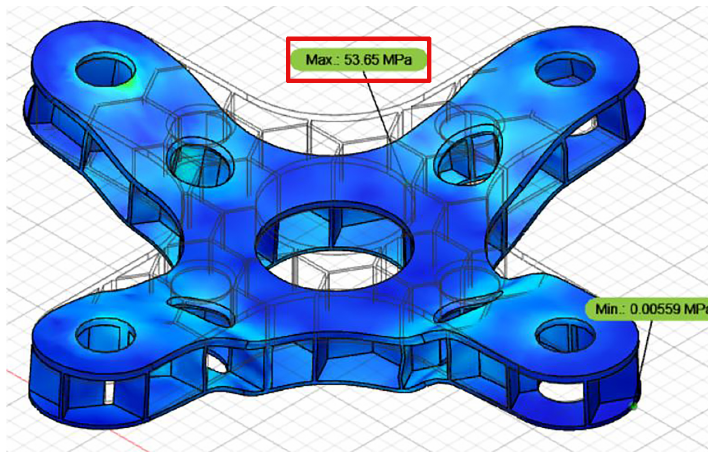
Figure 10. Stress analysis on the